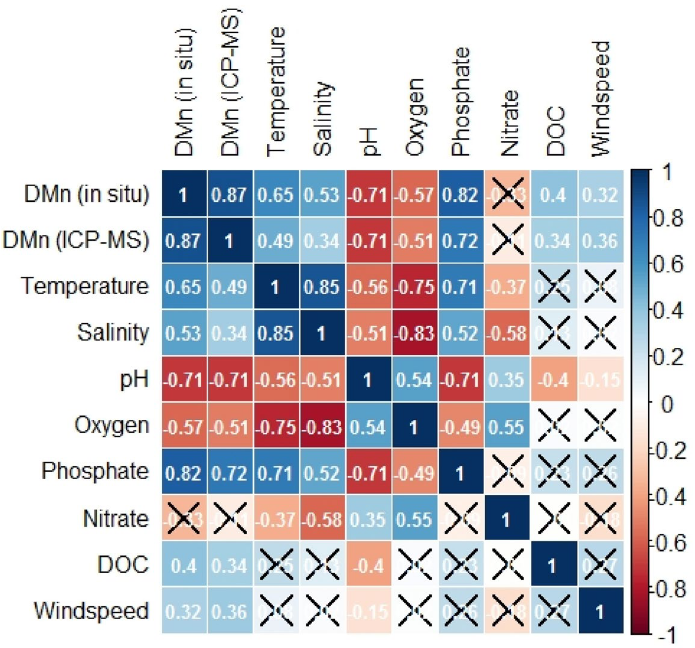
Figure 6. Spearman correlation matrix of in situ and discretely determined variables calculated with data points from October 22 to November 17, 2018; in situ DMn data for the period October 29 to November 07 were excluded for statistical analysis. Positive correlation coefficients are illustrated in blue boxes, negative ones in red. Not statistically significant correlations (p value ≥ 0.01) are